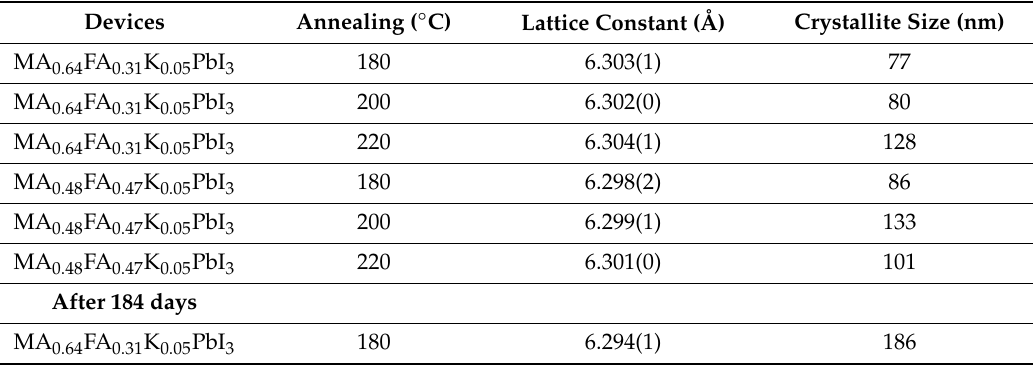
Table 2. Measured lattice constants and crystallite sizes of the perovskite compounds.